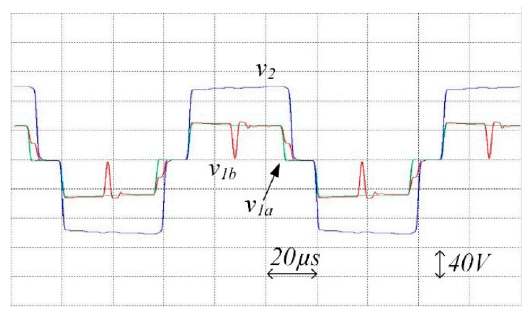
Figure 10. Voltages across windings of the proposed system fed from DC supplies with different duty cycles for each unit.